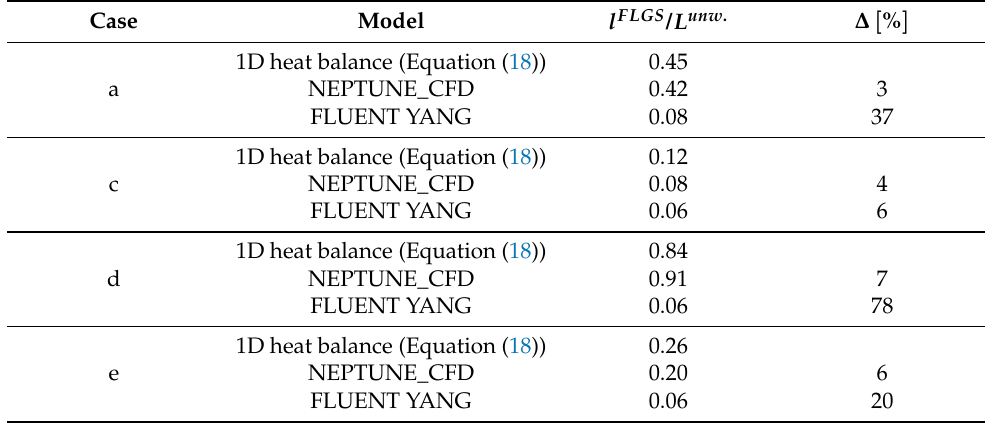
Table 3. Apparition position of the First Large Gas Structure for all the simulated